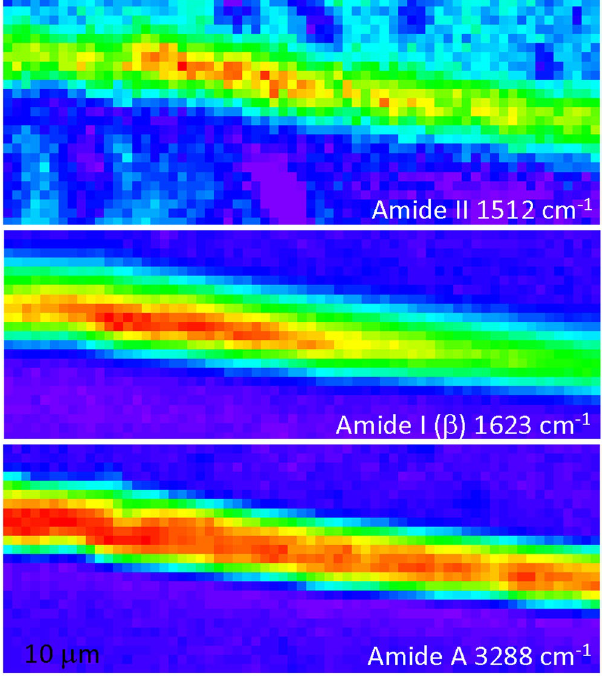
Figure 5. High resolution 1.9 μ m ATR FT-IR maps at 1.9 μ m resolution of the longitudinal (L) cross sections of silk presented in auto-scale for better viewing; a background-corrected absorbance is ranging from 0 to approximately 0.2. Lateral step size between pixels was 0.5 μ m; as-measured pixelated absorbance maps are presented. Polarisation of incident light onto ATR prism was s (in the plane of image; along